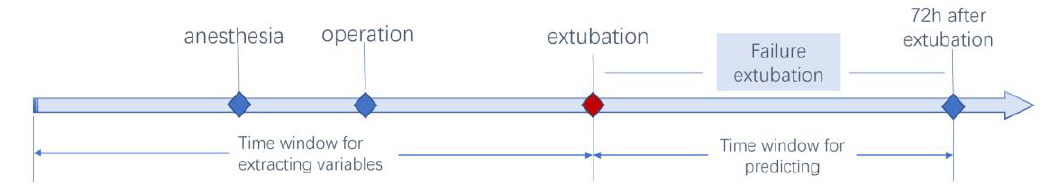
Figure 2. Data extraction and model